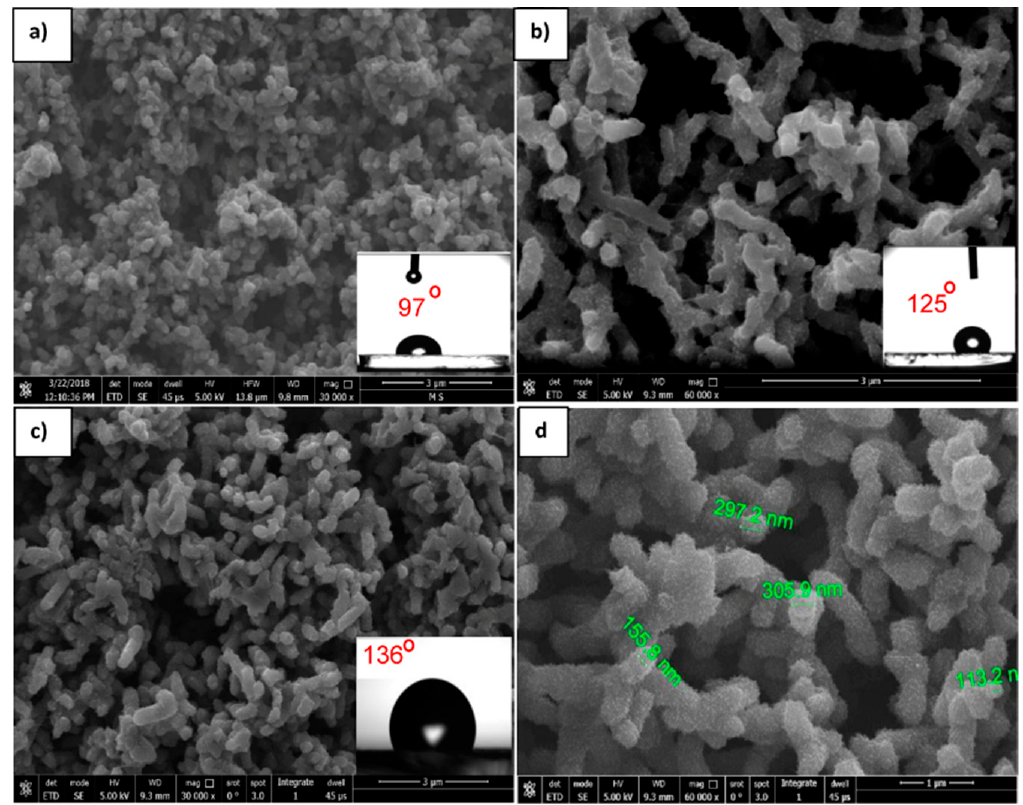
Figure 12. FE-SEM images of the PANI/ZnO nanocomposite with different ZnO contents: ( a ) 0, ( b ) 0.2 g/L, and ( c ) 0.5 g/L ZnO deposited at 30 cycles. ( d ) Higher magnification of ( c ). FE-SEM images show the water drop CAs imbedded on the respective surfaces.